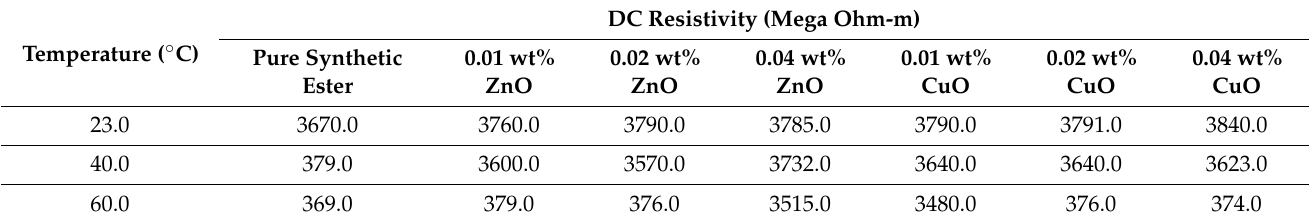
Table 5. DC Resistivity variation for different nanofluid samples with temperature.